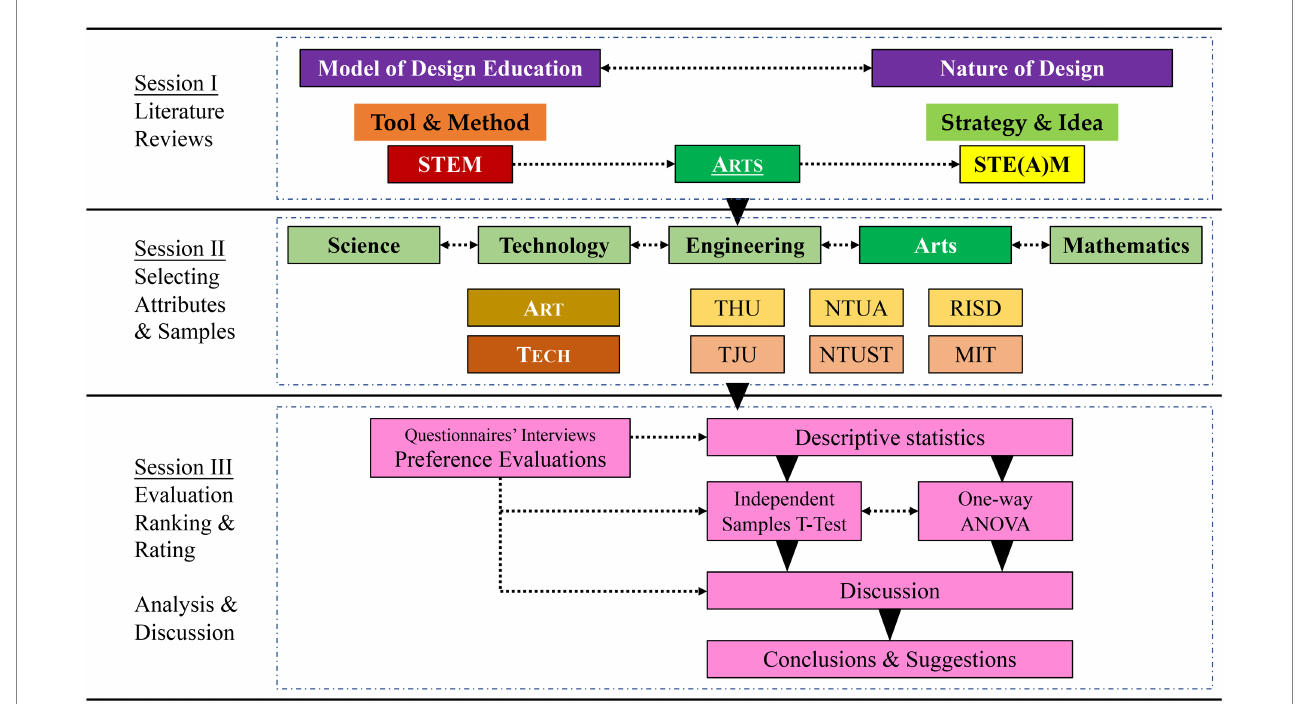
FIGURE 3 The procedures for deriving the effectiveness of the STEAM model which used in design education (Source: this